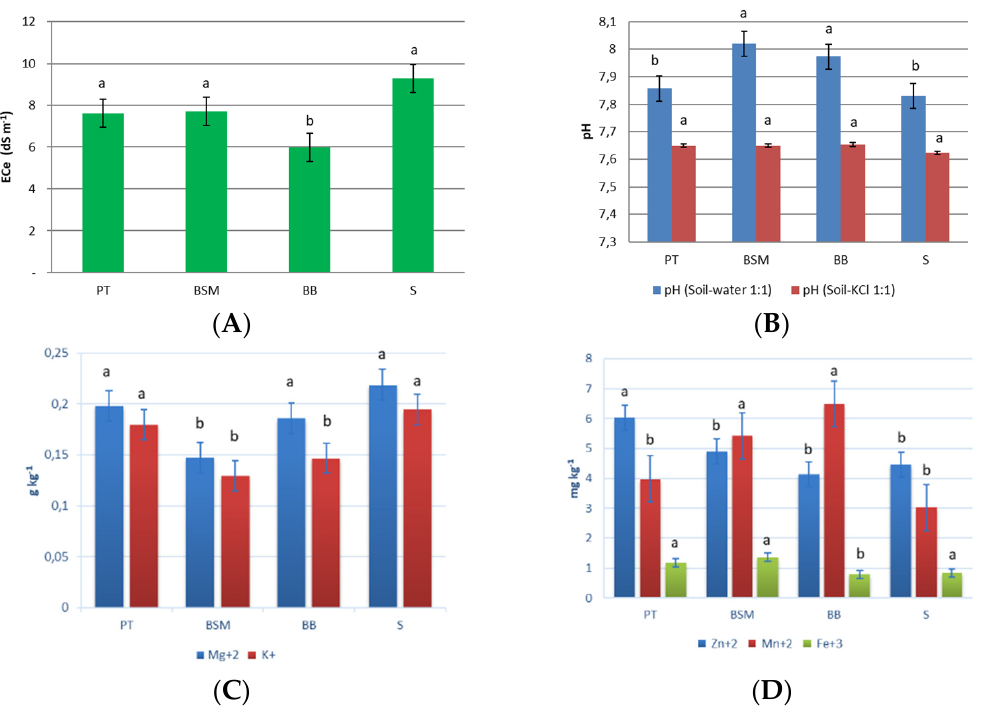
Figure 4. ( A ). pHw and pHk values in the different treatments. ( B ). EC values in the different treatments. ( C ). Macronutrient contents (Mg and K) in the soil. ( D ). Micronutrient contents (Zn, Mn, and Fe) in the soil. “a” and “b” indicate significant differences between treatments at the 95% confidence level.